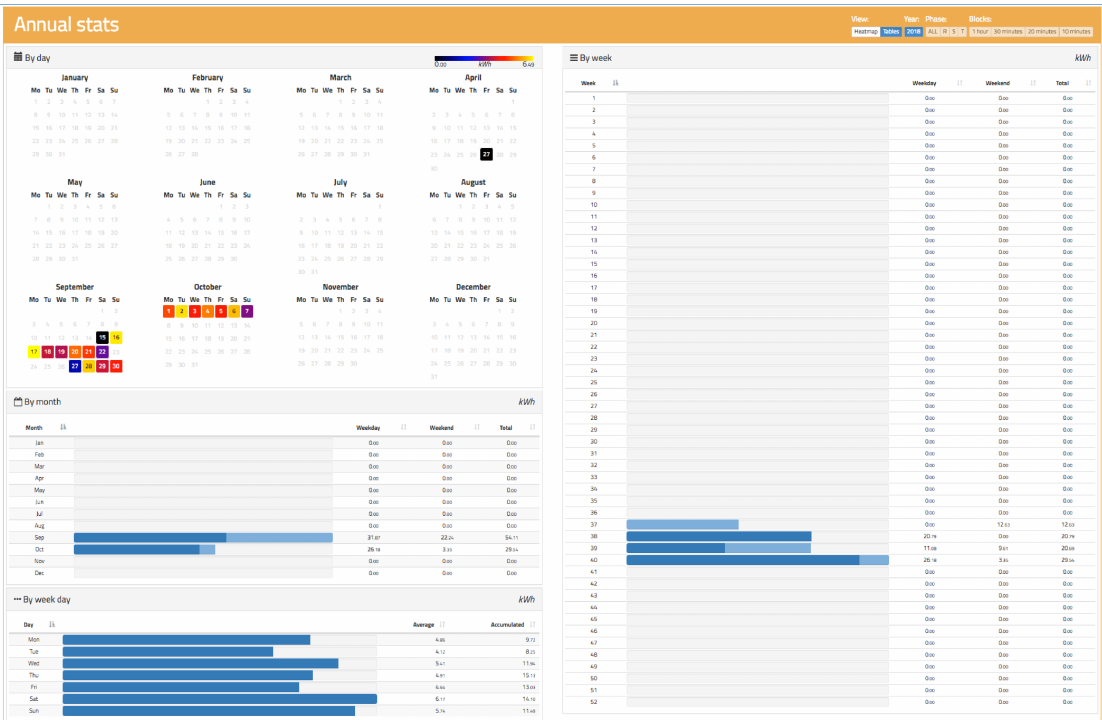
Figure 16. Active and reactive energy view of oZm.